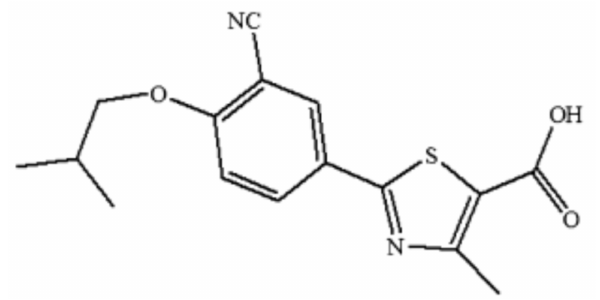
Figure 1. Molecular structure of febuxostat